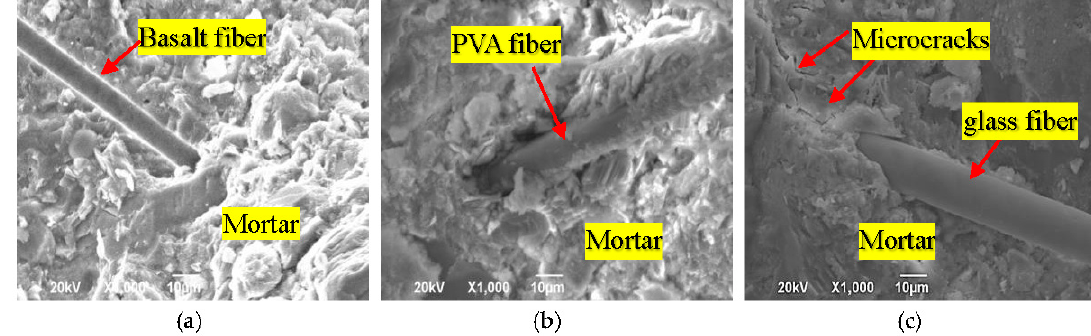
Figure 5. Interface between mortar and: ( a ) basalt fiber, ( b ) PVA fiber, and ( c ) glass fiber.